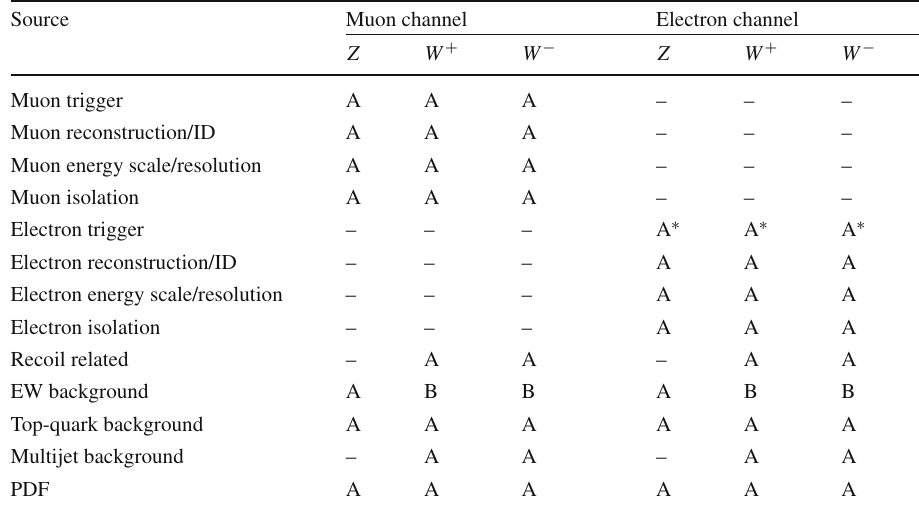
uncertainty given being statistical and the second uncertainty being the total systematic uncertainty, obtained by summing in quadrature the EW+top and multijet uncertainties. Uncertainties shown as ± 0 . 0 have a magnitude less than 0 . 05